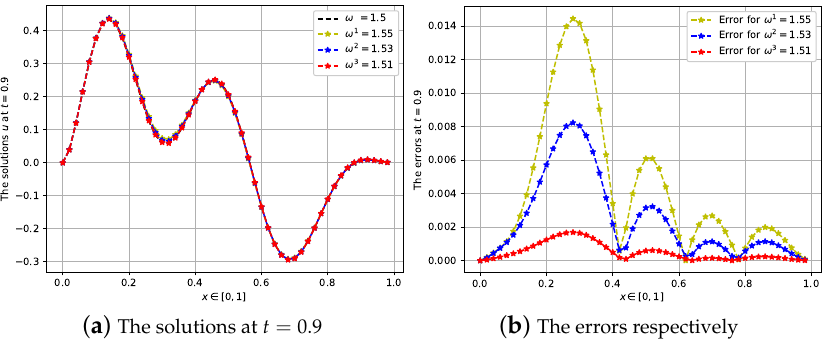
Figure 8. The solution u for ω = 1.5, ω i ∈ { 1.55,1.53,1.51 } at t = 0.9 and the respective error.